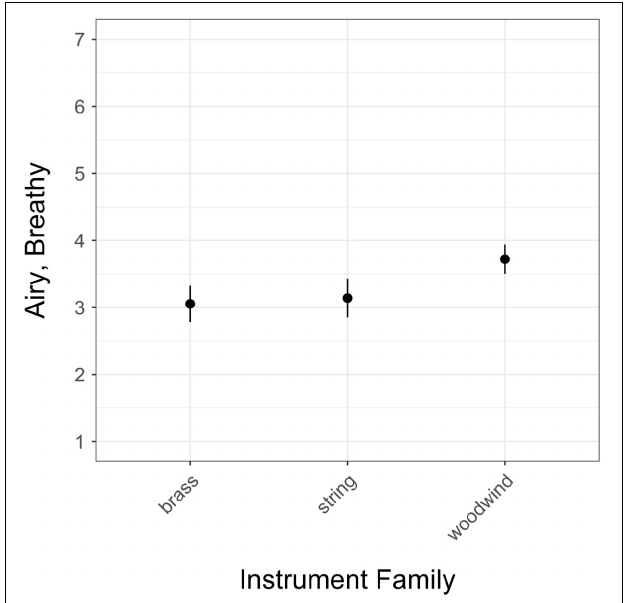
FIGURE 3 | Estimated marginal means for instrument family in the airy/breathy model; vertical bars represent 95% confidence